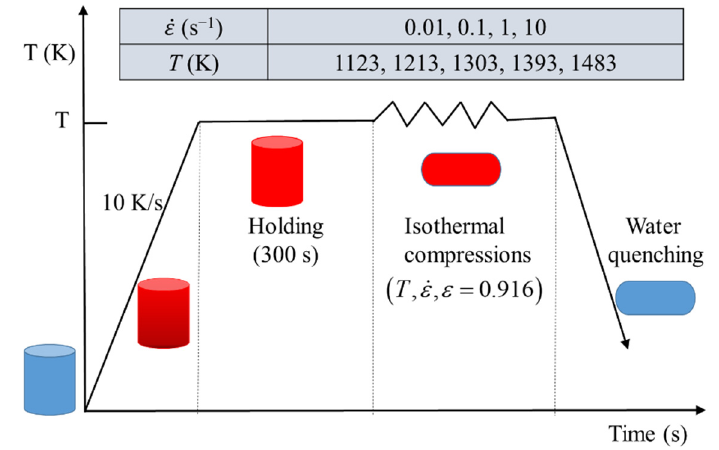
Figure 2. Processing routes of the isothermal compression test.